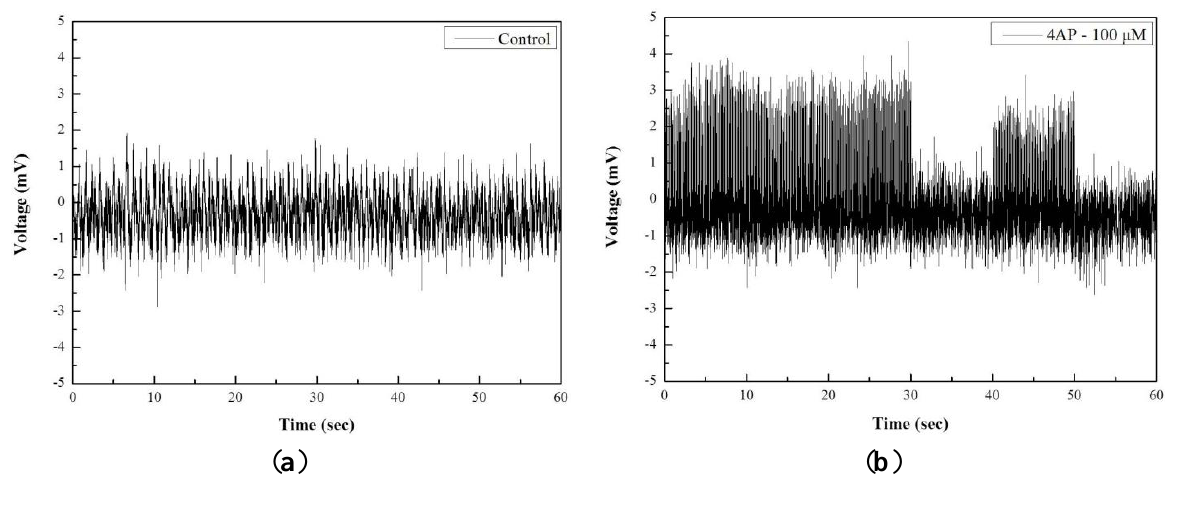
Figure 6. Extracellular neural spikes recording; ( a ) control cells; ( b ) 30 min after injection of 4-AP (100